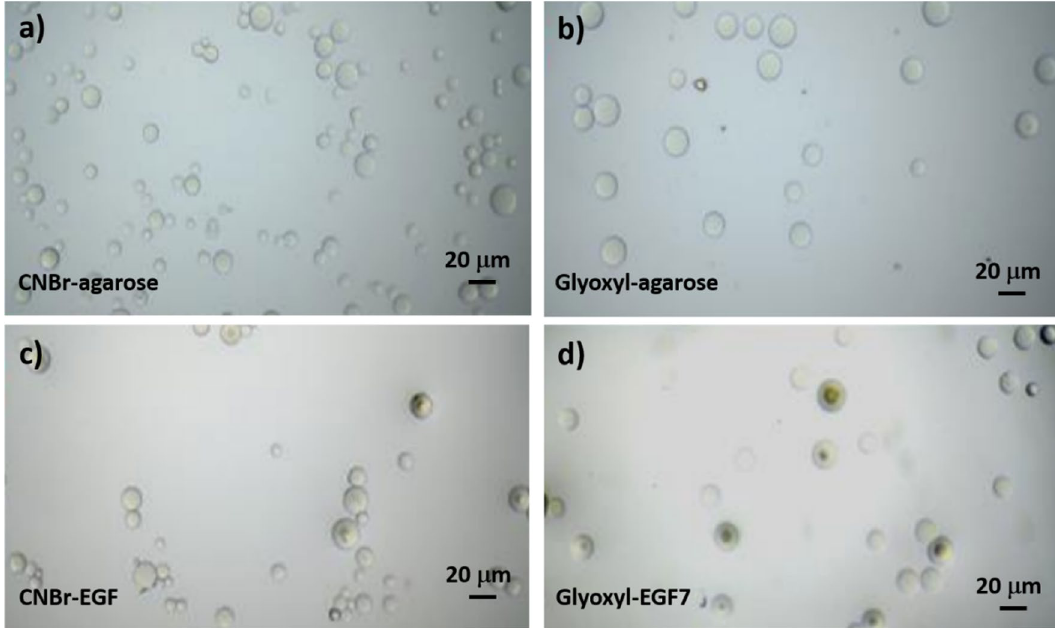
Figure 2. Microscopic images of CNBr-activated-agarose and glyoxyl-agarose carriers before ( a , b ) and after EGF immobilization ( c , d ), scale: × 40. For each sample n =